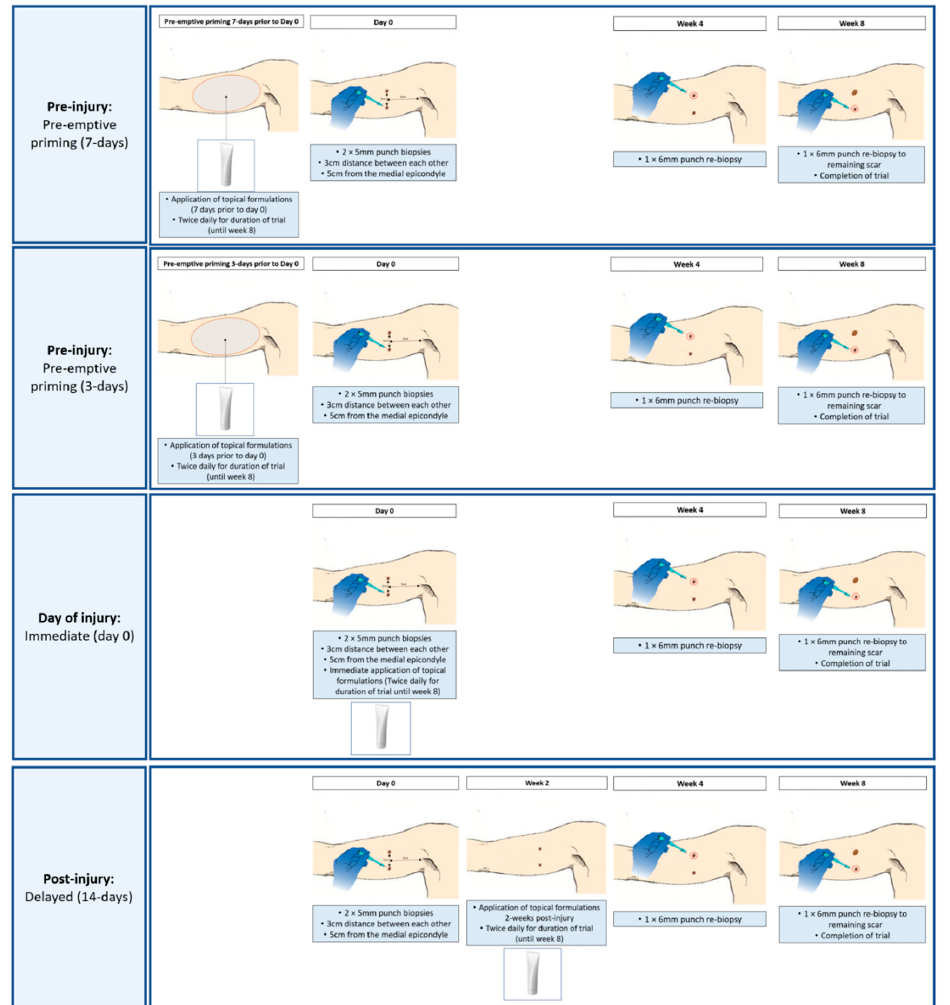
Figure 3. Punch biopsy methodology. Diagrammatic representation of the methodology for each of the groups (Pre-injury: pre-emptive priming (7-days), pre-injury: pre-emptive priming (3-days), day of injury (immediate application on day 0), post-injury (delayed 2 weeks post injury) including biopsy time points and time of topical applications. Each group applied both topical formulations twice daily for the duration of the study until week 8, with only the starting time point differing between groups.